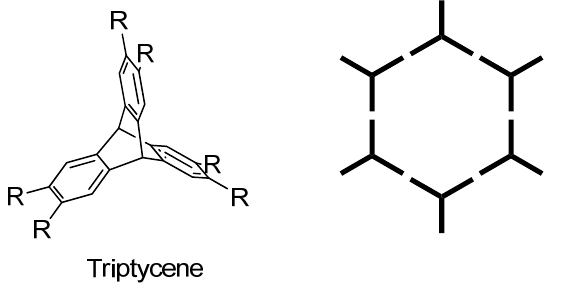
Figure 1. Triptycene (R=H) and binding motifs for pore